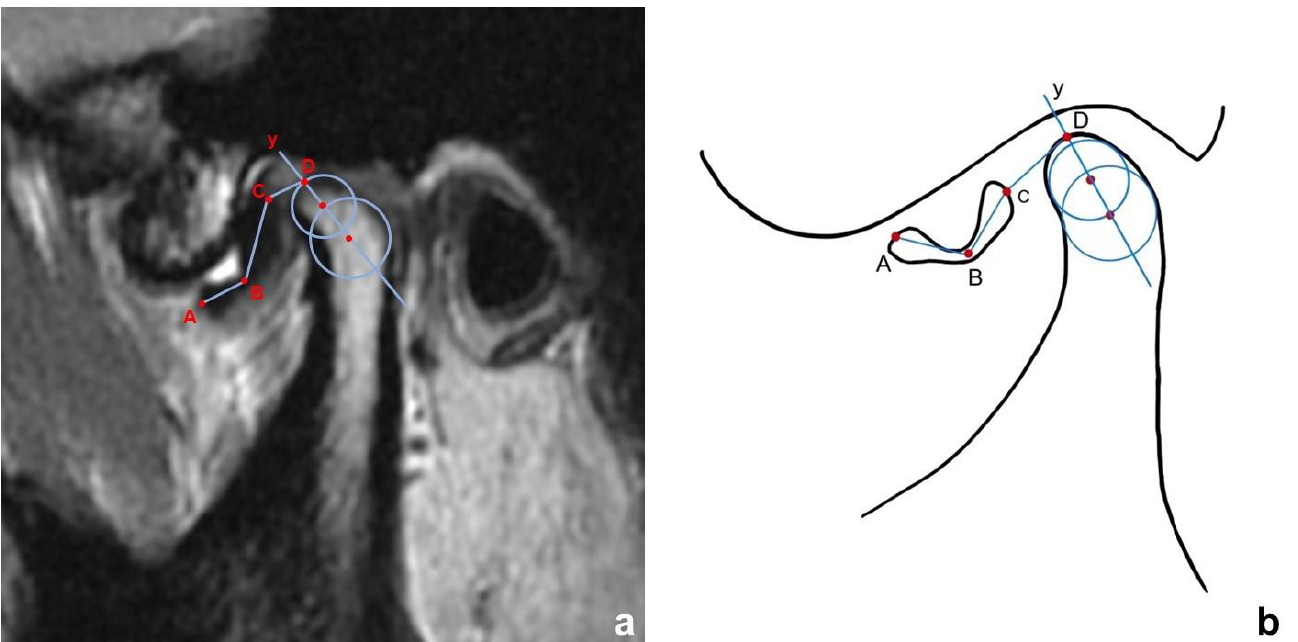
Figure 1. Measurement of quantitative disc variables. ( a ) true measurement on MRI; ( b ) measurement in diagrammatic sketch. Two circles were drawn to the internally tangent of the condyle. y, the long axis of the condyle; A, the midpoint of the most anterior edge of the disc; B, the midpoint of the intermediate zone; C, the midpoint of the posterior edge of the disc; D, the intersection of condylar long axis and contour of condylar cortical bone. Disc length equals to AB + BC; disc width is measured at point B; length-width ratio (L/W) is calculated as length divided by width; distance between the disc and condylar head equals CD, which equals the disc displacement distance in ADD cases.